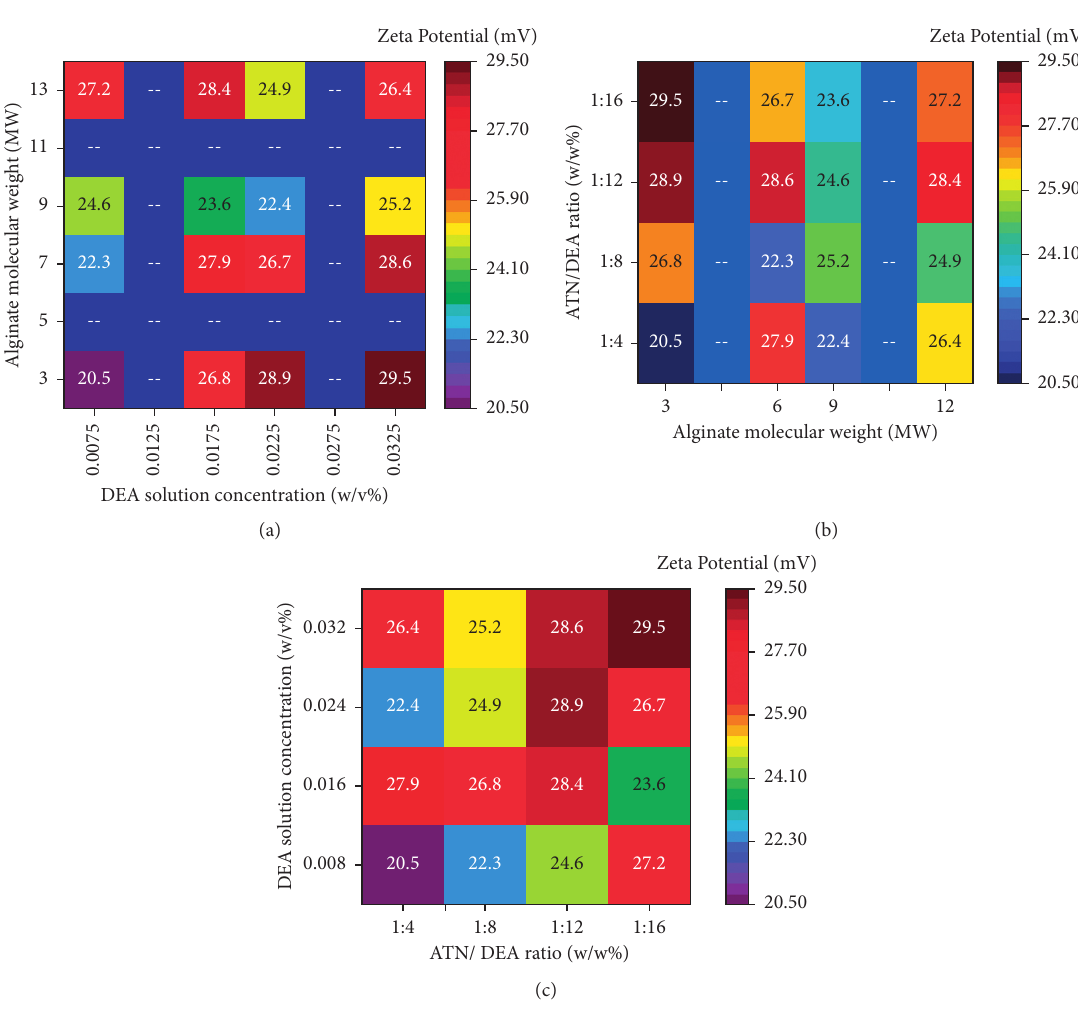
Figure 7: Heatmap plot analysis for zeta potential effects with the combination of factors: (a) DEA solution concentration and alginate molecular weight, (b) alginate molecular weight and ATN/DEA ratio, and (c) ATN/DEA ratio and DEA solution